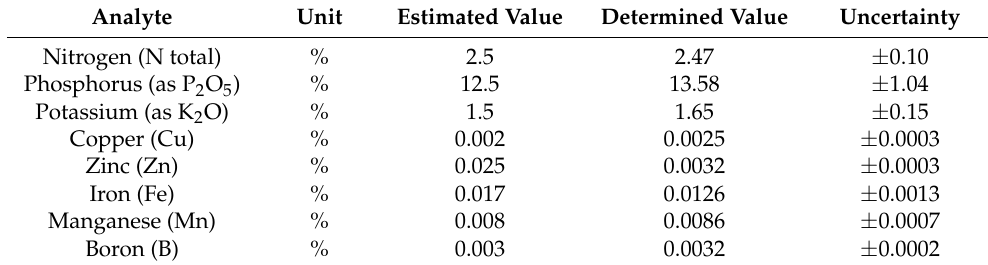
Table 3. Composition of the prepared foliar fertilizer, NanoFert Z, estimated value (according to receipt) and determined value.